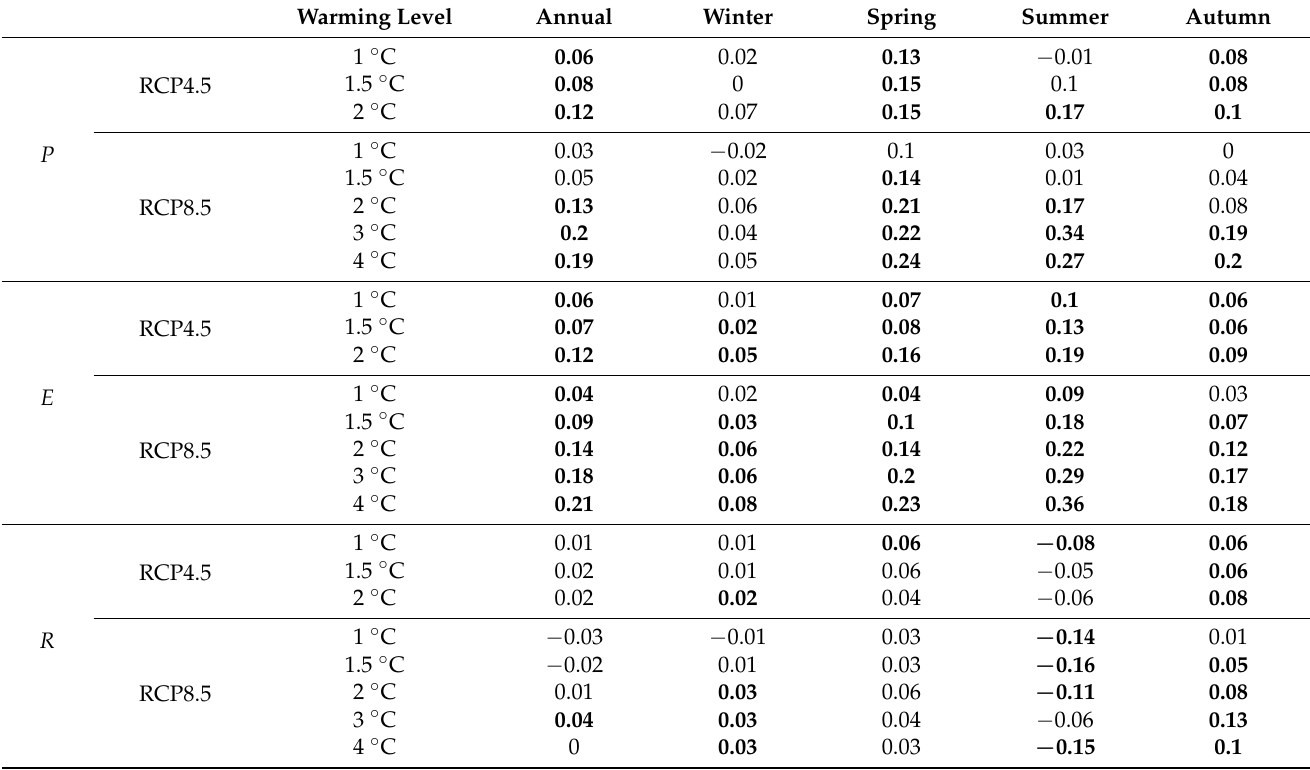
Table 4. Projected changes (mm/day) in precipitation, evapotranspiration, and runoff at different warming levels ( P , E , and R denote precipitation, evapotranspiration, and runoff,